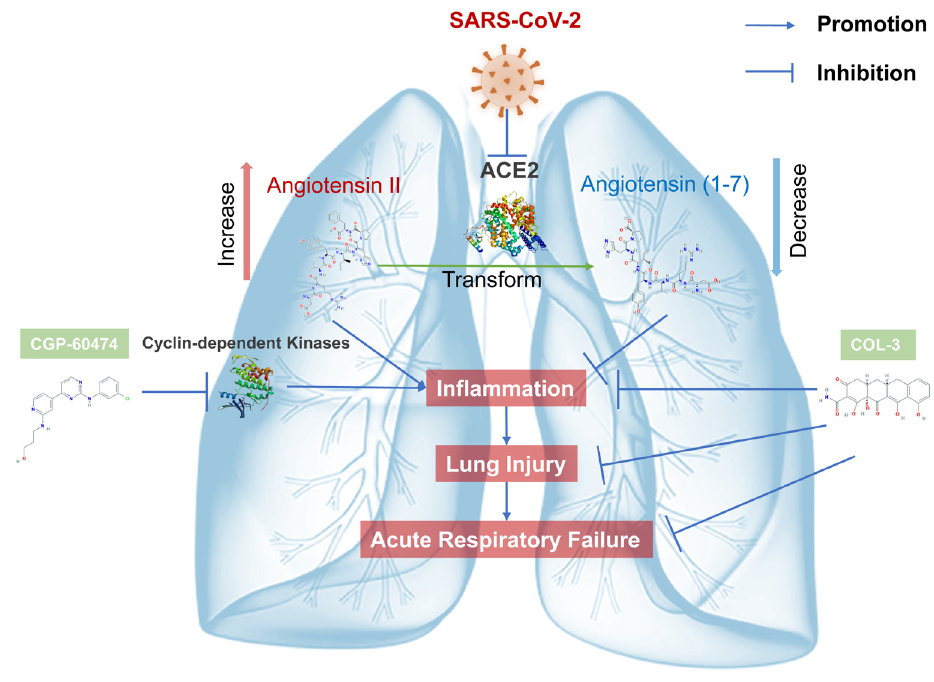
Figure 5. Proposed mechanisms of lung injury in COVID-19 through ACE2 and the therapeutic effects of COL-3 and